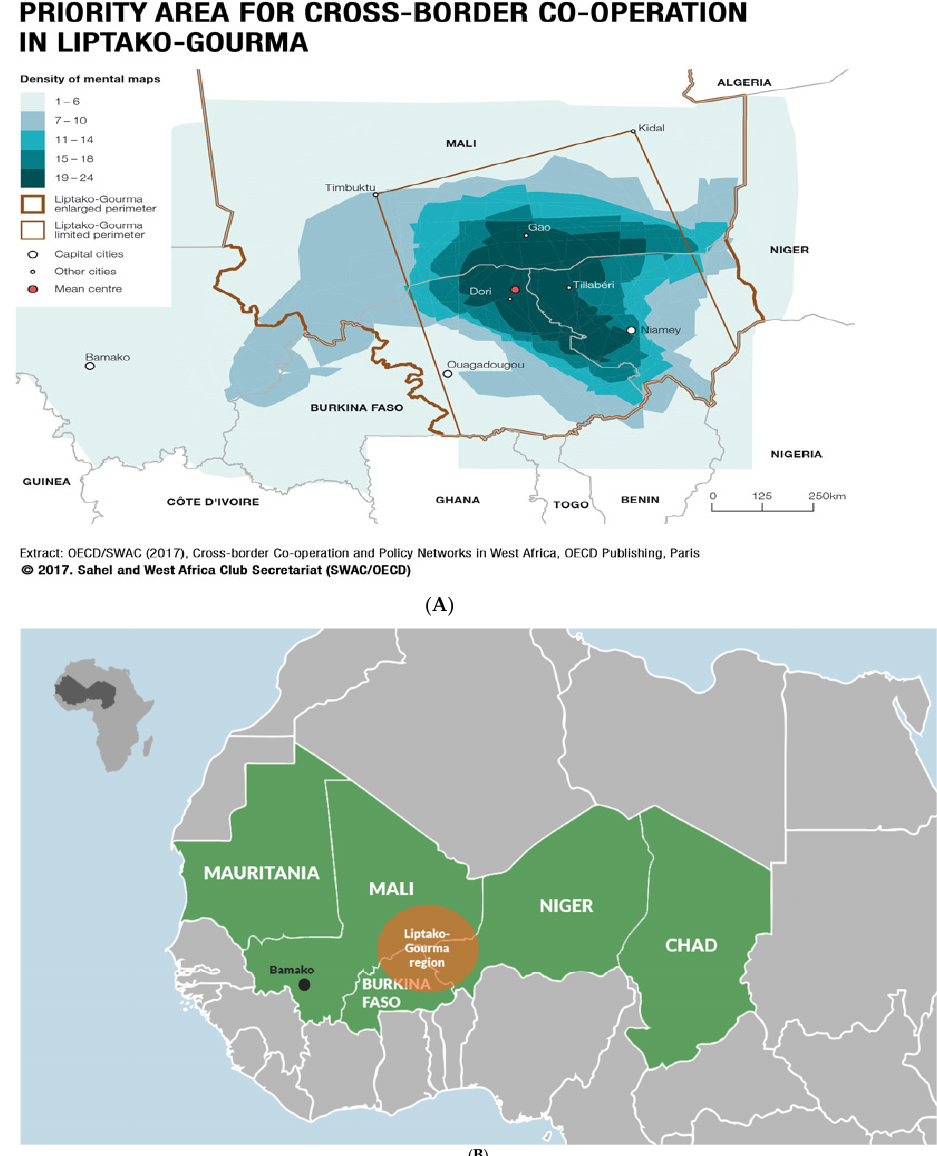
Figure 1. ( A ) Mapping the Challenges of the Liptako-Gourma Region: Understanding the Complexi- ties of Borderland Governance and Development: Source OECD; ( B ) Exploring the Dynamics of Livelihood Strategies and Fragility in the Liptako-Gourma Region: A Geospatial Analysis: Source: Daily Maverick, Africa. There are three principal and open grazing zones critical for farmers and pastoralists in the Oudalan province, including the area of 107,000 ha of the ‘forage christine’, 50,000 ha ‘beli’, and the 15,000 ha around Oursi pond. While the pastoral zone is an open and rich source of water and grazing zone, the major constraint is the water availability during the dry season, particularly from March to June, which becomes the most challenging pe- riod for pastoralists. Due to the changes in rainfall patterns, including flooding, drought, and shift of the rainy season, as well as the extreme heat waves in the Sahel resulting from climate change, the Oudalan province in the Sahel region has been identified as one of the zones most vulnerable to climate change [34]. The Oudalan province is also known for the artisanal mining of gold. The 2017 survey identified 53 mines in the east, and its annual production is estimated to be 11 billion CFA francs [35]. Per the study, illegal export of gold to neighboring countries is being done to evade taxes, which has led to concentration of extremist groups mainly in the border areas between “Burkina Faso, Niger, and Mali”. Consequently, this illicit economic activity has played both strategic and significant role in causing environmental instability in the region [36]. Recently, there has been a notable escalation of conflicts in the Liptako-Gourma regions, as multiple sources have reported the existence of violent extremist organizations, Malian armed groups that have signed the peace agreement, and self-defense groups. They are directly or indirectly involved in illicit activities and local conflicts [36]. Traditionally, conflict resolution is managed by the local authorities through informal discussion with the Oudalan provincial government as well as the study on natural resource management in Oudalan province. However, due to the sharp increase in insurgencies, the traditional authorities’ ability to resolve disputes is weakening. For example, some local authorities in Oudalan province left their communities due to death threats by an armed group. In the absence of local authorities, the extremist group’s power turned them into ‘mediators’ capable of settling